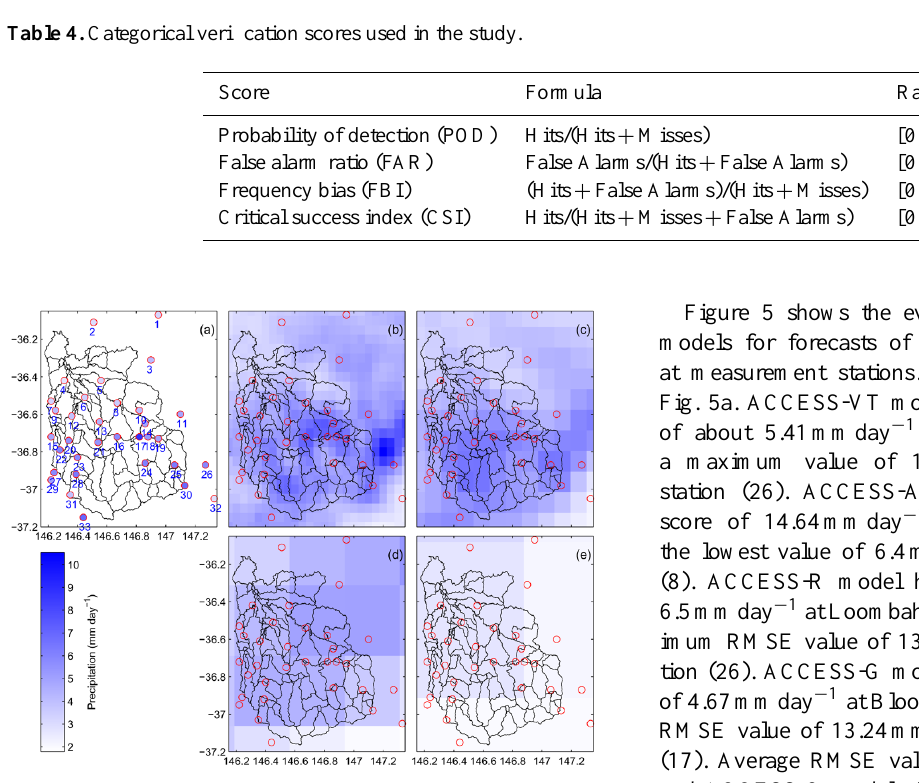
Fig. 4. A comparison of daily average (1–24h accumulated) ob- served precipitation at stations and forecasted precipitation by the ACCESS models in Ovens catchment for 1 April 2010 to 8 Febru- ary 2011: (a) Observed station precipitation, (b) ACCESS-VT, (c) ACCESS-A, (d) ACCESS-R, and (e)